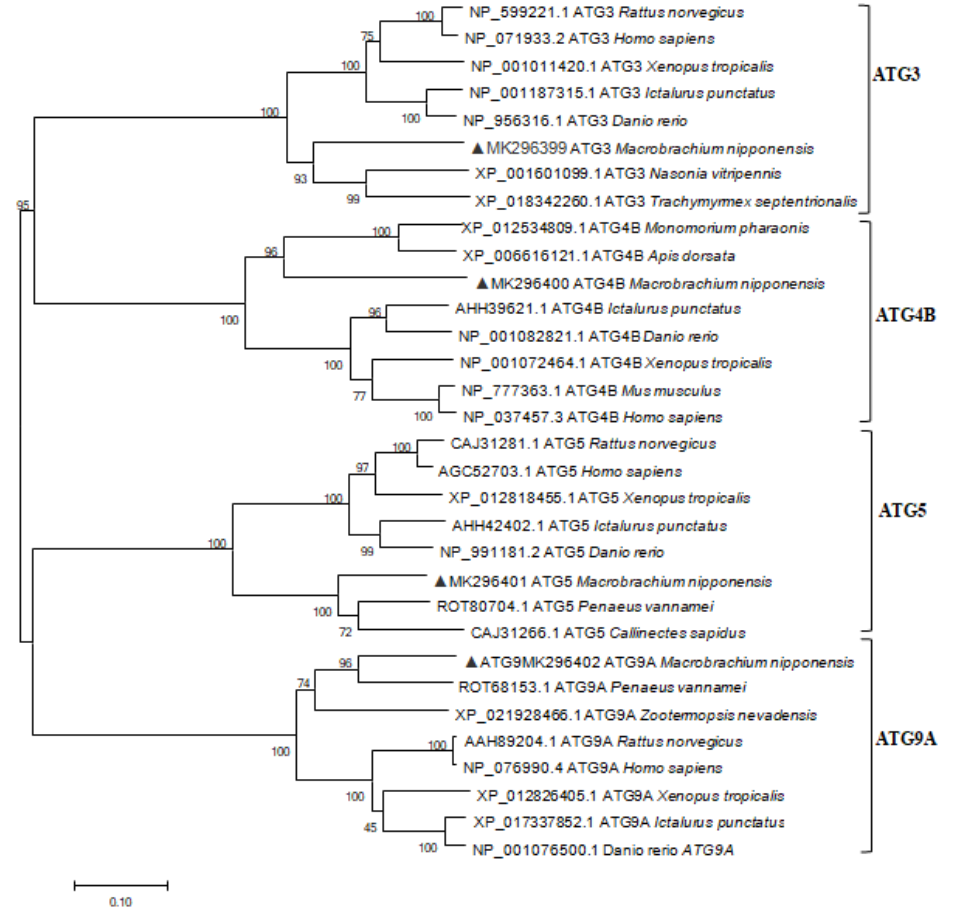
Figure 2. Phylogenetic tree of autophagy-related genes from M. nipponense and related organisms constructed using the neighbor-joining method with Molecular Evolutionary Genetics Analysis software version 4.0 (MEGA4) (available online: http: // www.megasoftware.net / mega4 / mega.html, access date: 12 April 2019). Numbers at branches indicate percentage bootstrap